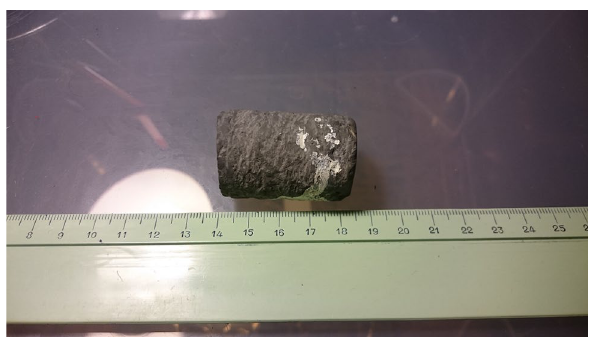
Fig. 4 Rock sample used for pyrolysis analysis